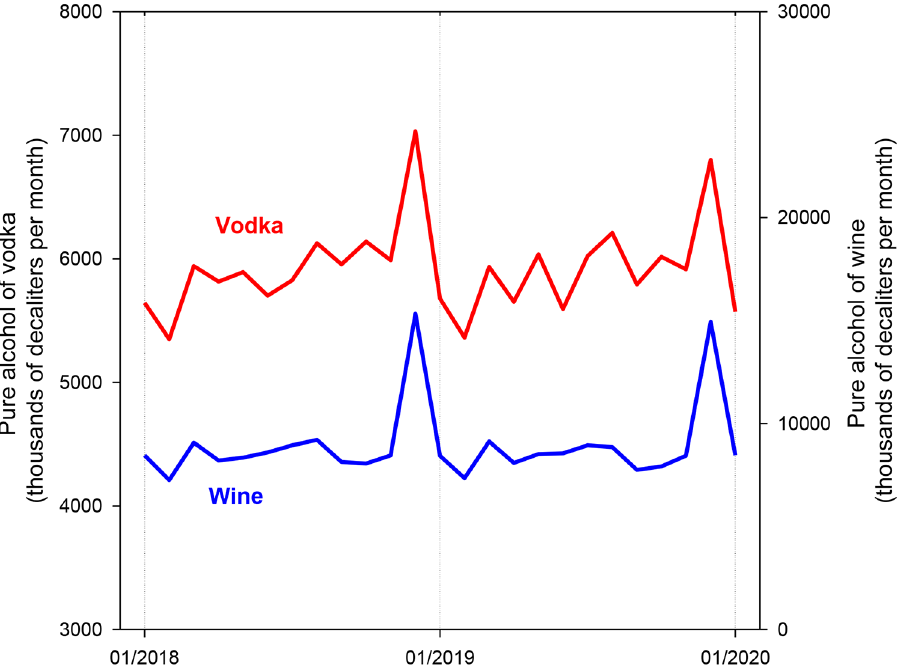
Fig. 8. Retail sales of vodka (left axis) and wine (right axis) from January 2018 to January 2020 esti- mated in pure alcohol volume. Source: authors’ calculations based on Rosstat